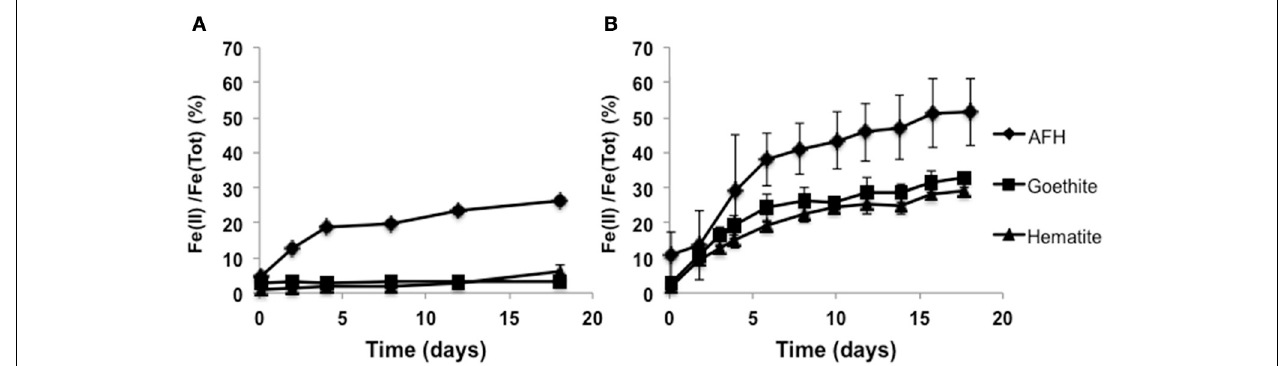
FIGURE 5 | Microbial iron reduction by the enrichment cultures IBDP5655 (A) and IBDP6634 (B) in the presence of different iron minerals. pH of the cultures was approximately 6.2. All the samples were prepared in duplicate and the error bars indicate standard